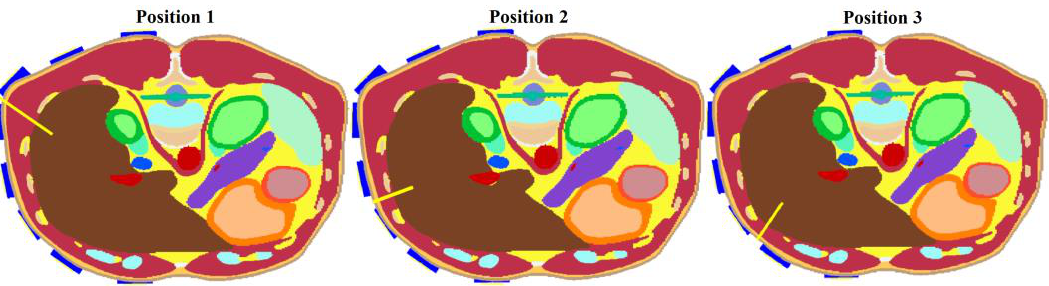
Figure 5. Tested positions of the RFA catheter within the heterogeneous numerical model. The solid yellow line represents the RF catheter.